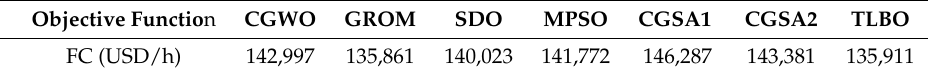
Table 13. Results of the GROM and other optimization algorithms for large scale system (IEEE 118-bus system).